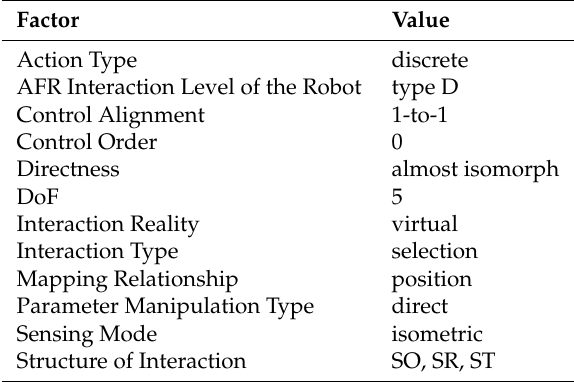
Table 2. Interaction parameter.